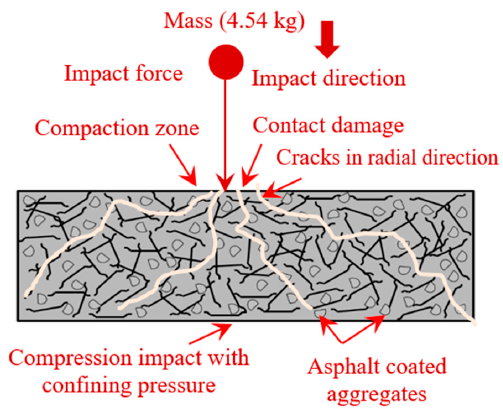
Figure 18. Aggregate failure mechanism.